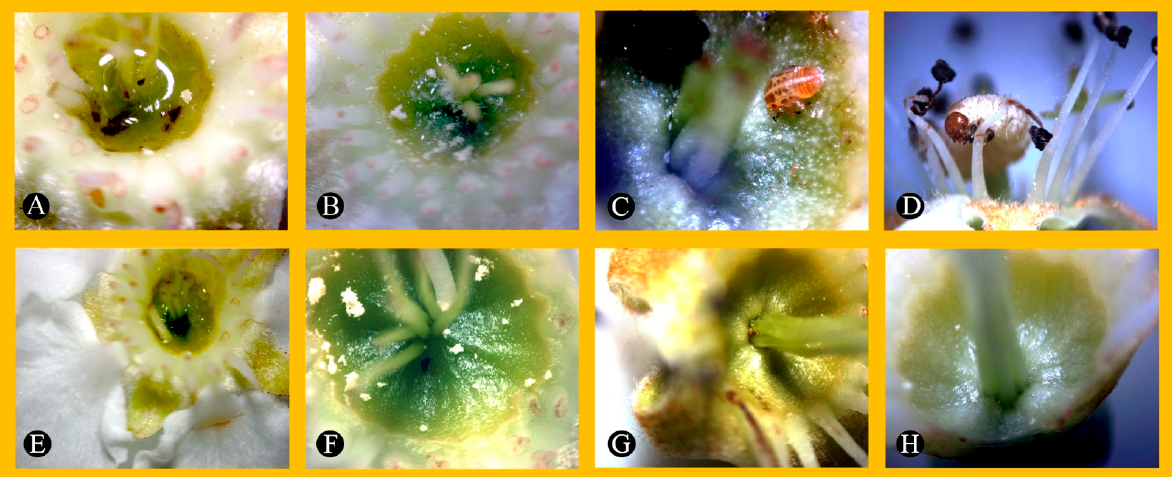
Figure 3. Transversally cut flowers of three pear cultivars showing nectar contained in plate-like nectariferous area of hypanthium The remaining basal parts of five petals, numerous stamens and five styles are noticeable. (( A ) Chojuro; ( B ) Nijisseiki; ( C , D ) Bella di Giugno; ( E ) Alexander Lucas; ( F ) Willimas; ( G ) Poire de Cure; ( H ) Kieffer) (×1.5; stereomicroscopy). Observation under SEM has revealed the differences among cultivars in the surface structure of nectary relating to the cuticle patterns, the shape of epidermal cells, the appearance and distribution of stomata. Scanning electron microscopy also allowed nectar droplets to be observed in different phases of secretion (Figures 4 and 5).